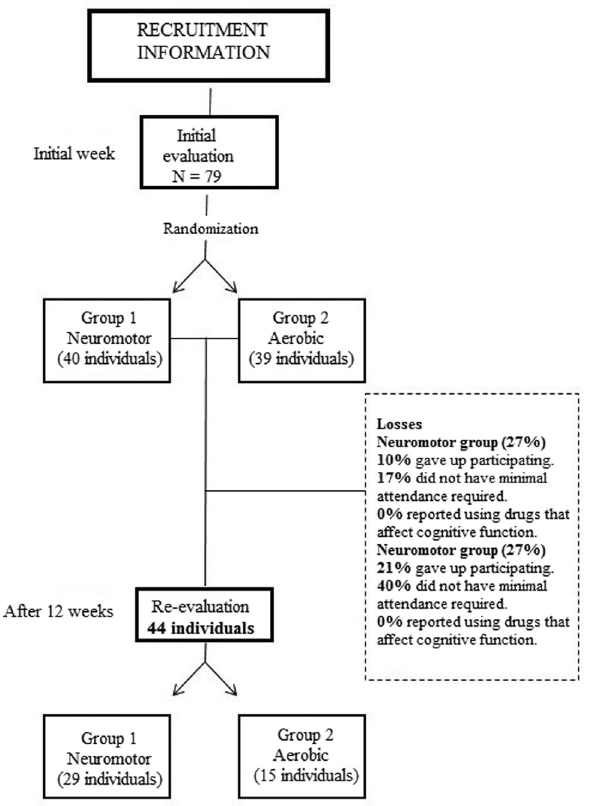
Figure 1 - Fluxorama of the